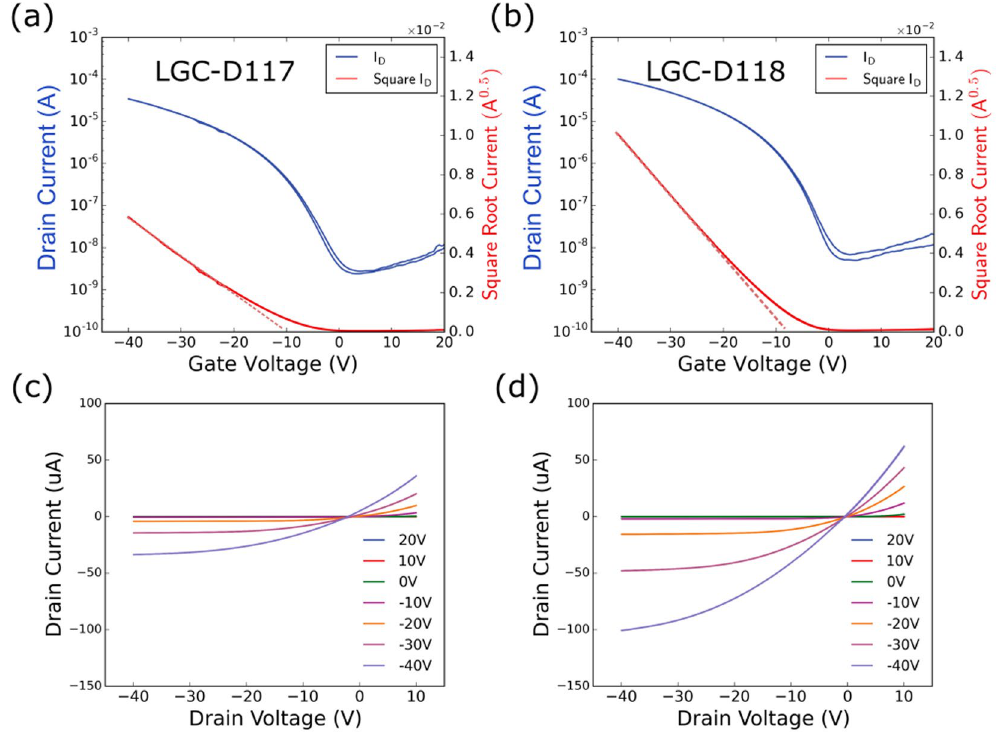
Figure 3. Typical transfer and output curves of organic field-effect transistors based on LGC-D117 and LGC- D118 OSCs after annealing at 100 °C. (V sd = − 40 V).